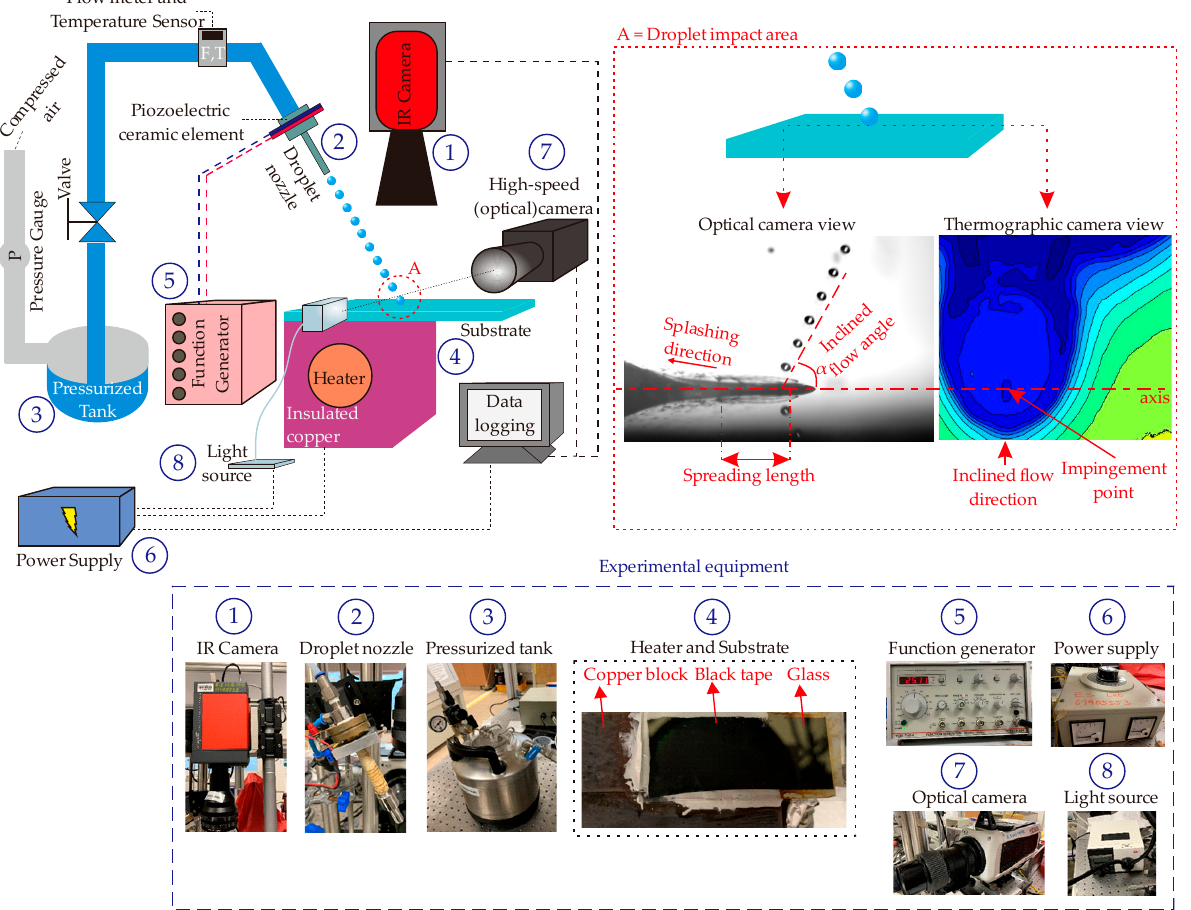
Figure 1. Simplified schematic of the experimental setup.